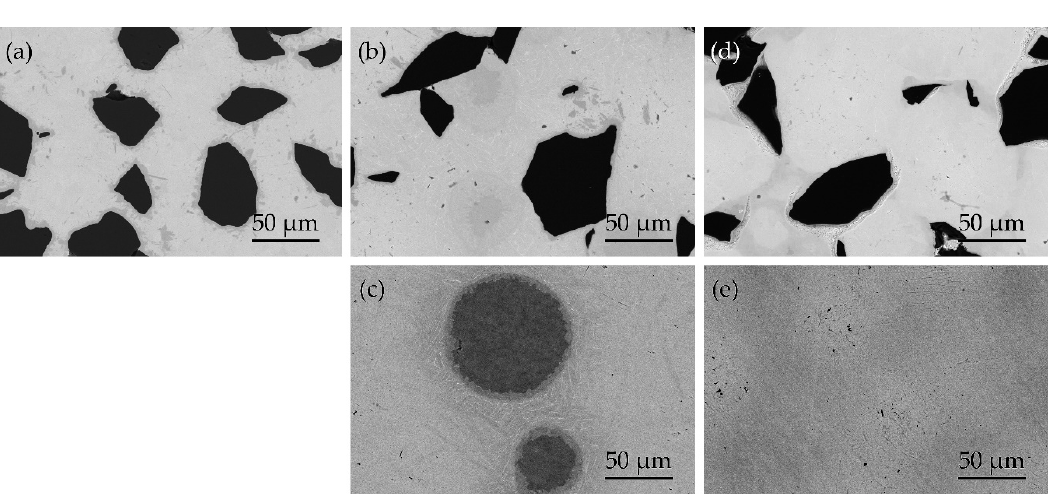
Figure 2. CBS-SEM (circular backscattered-scanning electron microscopies) images: ( a ) Ti + 30 vol. % B 4 C, ( b ) Ti + 30 vol. % B 4 C + 20 vol. % Ti-Al(1), ( c ) Ti + 20 vol. % Ti-Al(1), ( d ) Ti + 30 vol. % B 4 C + 20 vol. % Ti-Al(2) and ( e ) Ti + 20 vol. % Ti-Al(2).